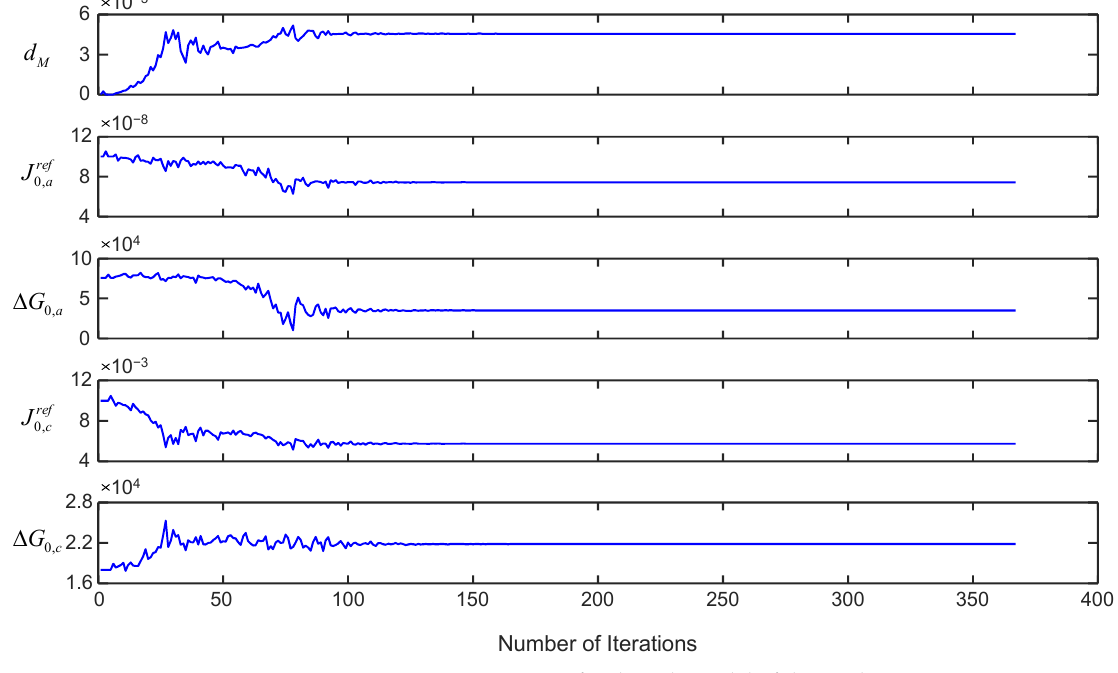
Figure 20. Parameter estimation for the sub-model of the